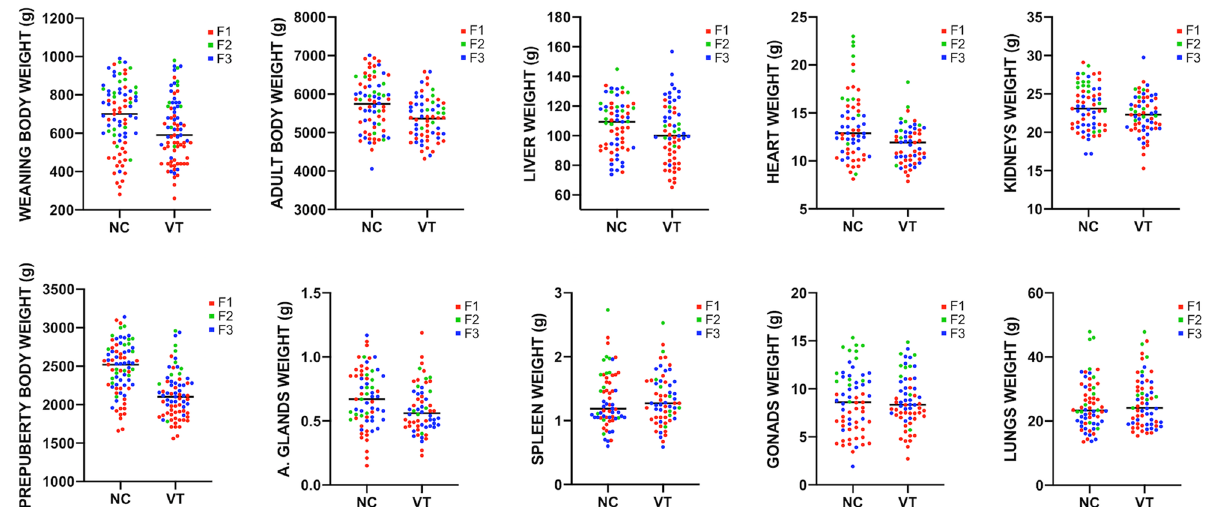
Figure 4. Scatterplots showing the phenotypic raw data distributions of naturally-conceived (NC) and vitrified- transferred (VT) progenies during three generations (F1, F2,